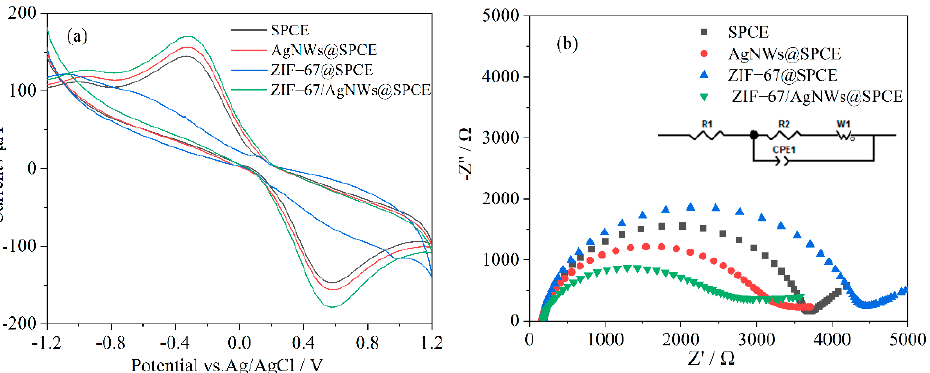
Figure 3. CV curves ( a ) and EIS ( b ) curves for bare SPCE and SPCE modified with ZIF − 67 and ZIF − 67/AgNWs. Electrolyte solution containing [Fe (CN) 6 ] 3 − /4 − (1 mM) as an electrochemical signal probe.